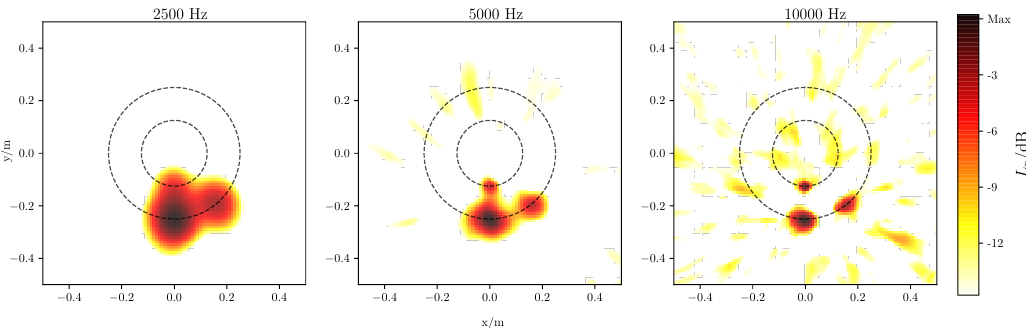
Figure 5. Octave band source maps for 2.5, 5 and 10 kHz obtained with the spiral array and barycentric interpolation between the microphones.